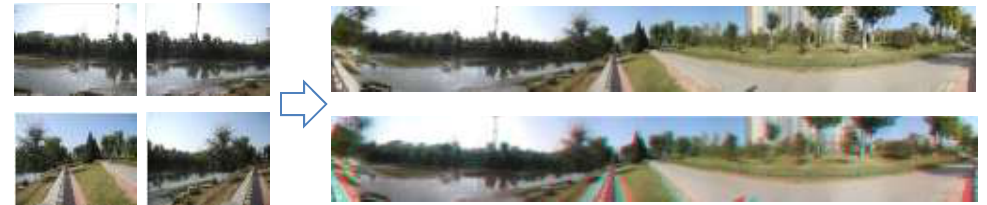
Figure 9. A panorama (right upper) and a synthesized stereo (right